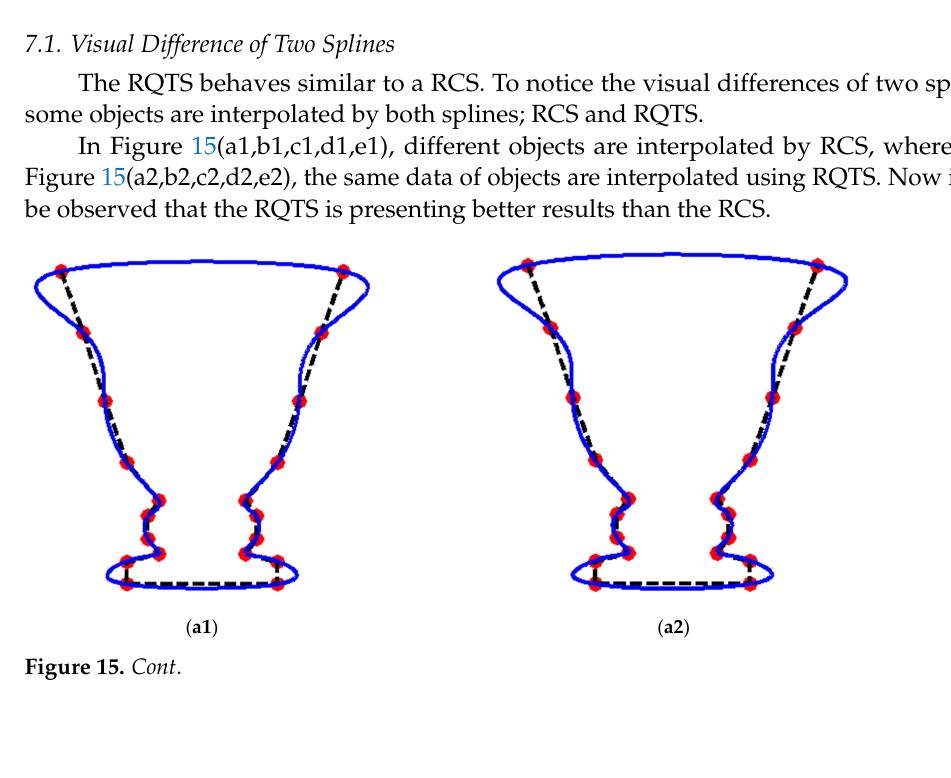
( d ) Figure 13. ( a – d ) are RQTS curve through biased tension, by 𝜎 (cid:3038) (cid:3404) 2,3,5 , and 10 for any k th inter ‐ val. Figure 9b–d demonstrate that rising values of shape constraints 𝜌 (cid:3038) (cid:3404) 𝜎 (cid:3038) (cid:3404) 3, 5 and 100, for the base interval to stretch the curve in the base interval and consequently re ‐ veal interval tension. Figure 10b–d illustrate the biased tension with the increasing value of 𝜌 (cid:3036) (cid:3404) 3, 5 and 10. Similarly biased global tension is shown in Figure 11b–d with the increasing values of 𝜎 (cid:3036) (cid:3404) 3, 5 and 10. Whereas biased interval tension is also demon ‐ strated in Figures 12b–d and 13b–d with the increasing values of 𝜌 (cid:3038) (cid:3404) 3, 5 and 10, and